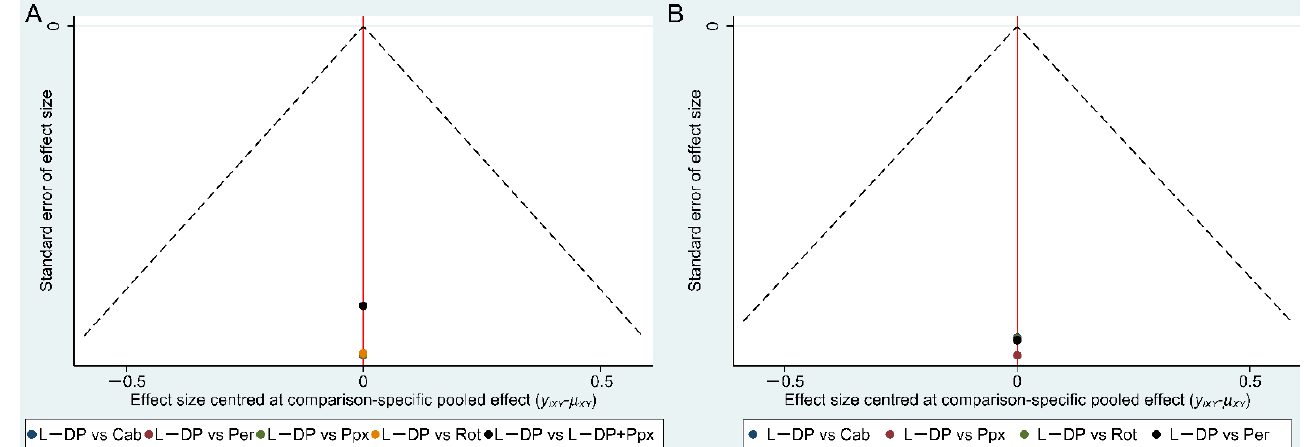
Figure 4. Surface under the cumulative ranking curve (SUCRA). ( A ) SUCRA of all included drugs on letter fluency; ( B ) SUCRA of all included drugs on semantic fluency.